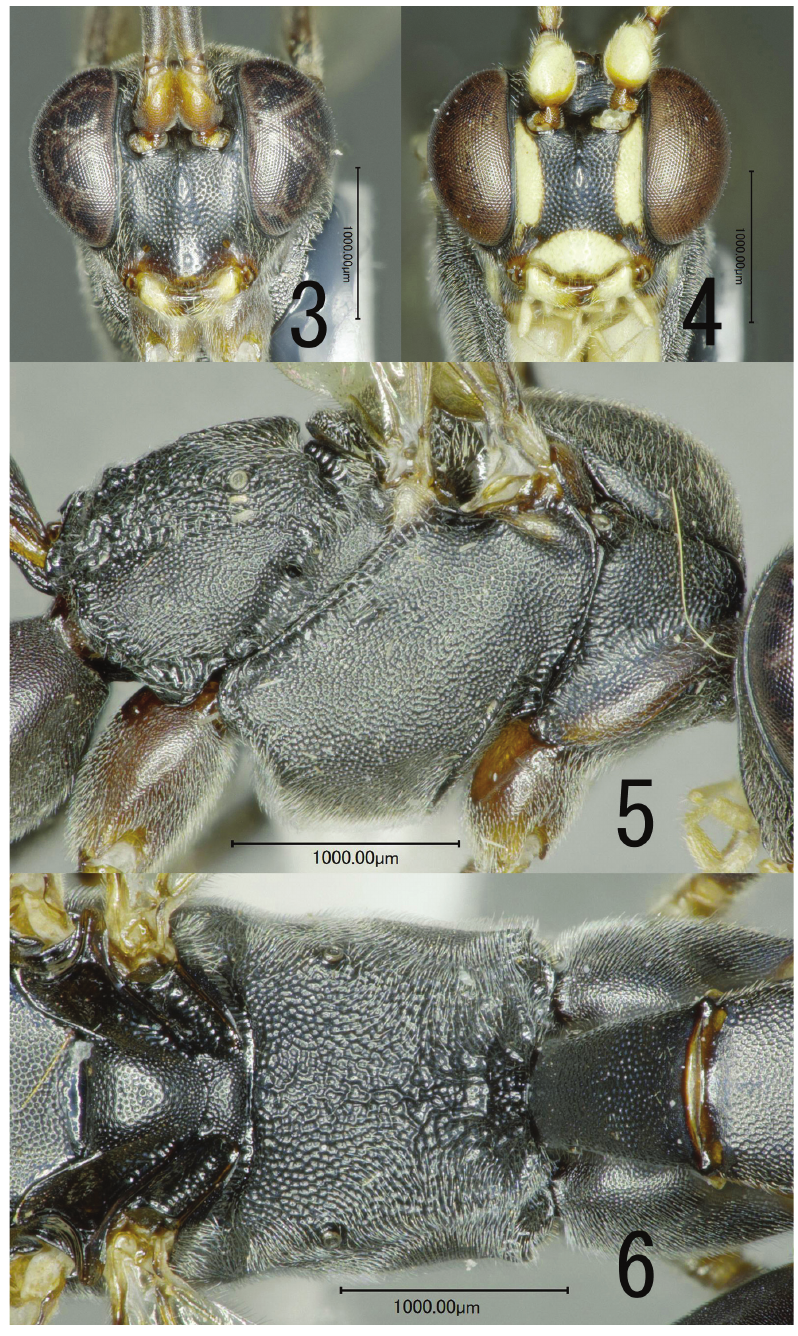
Figures 3–6. C. sulawesiensis sp. n. 3 Head, frontal view, female (holotype) 4 head, frontal view, male (paratype) 5 mesosoma, lateral view, female (holotype) 6 propodeum, dorsal view, female (holotype). Scale bar: 1.0